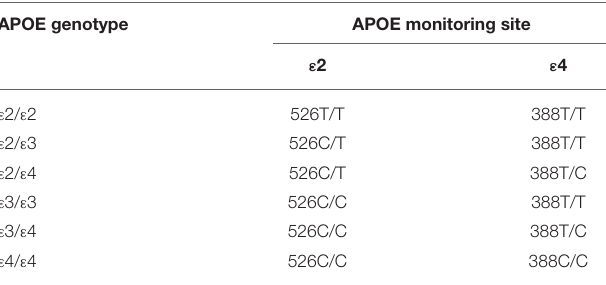
TABLE 1 | Apolipoprotein E gene (APOE) genotype decision